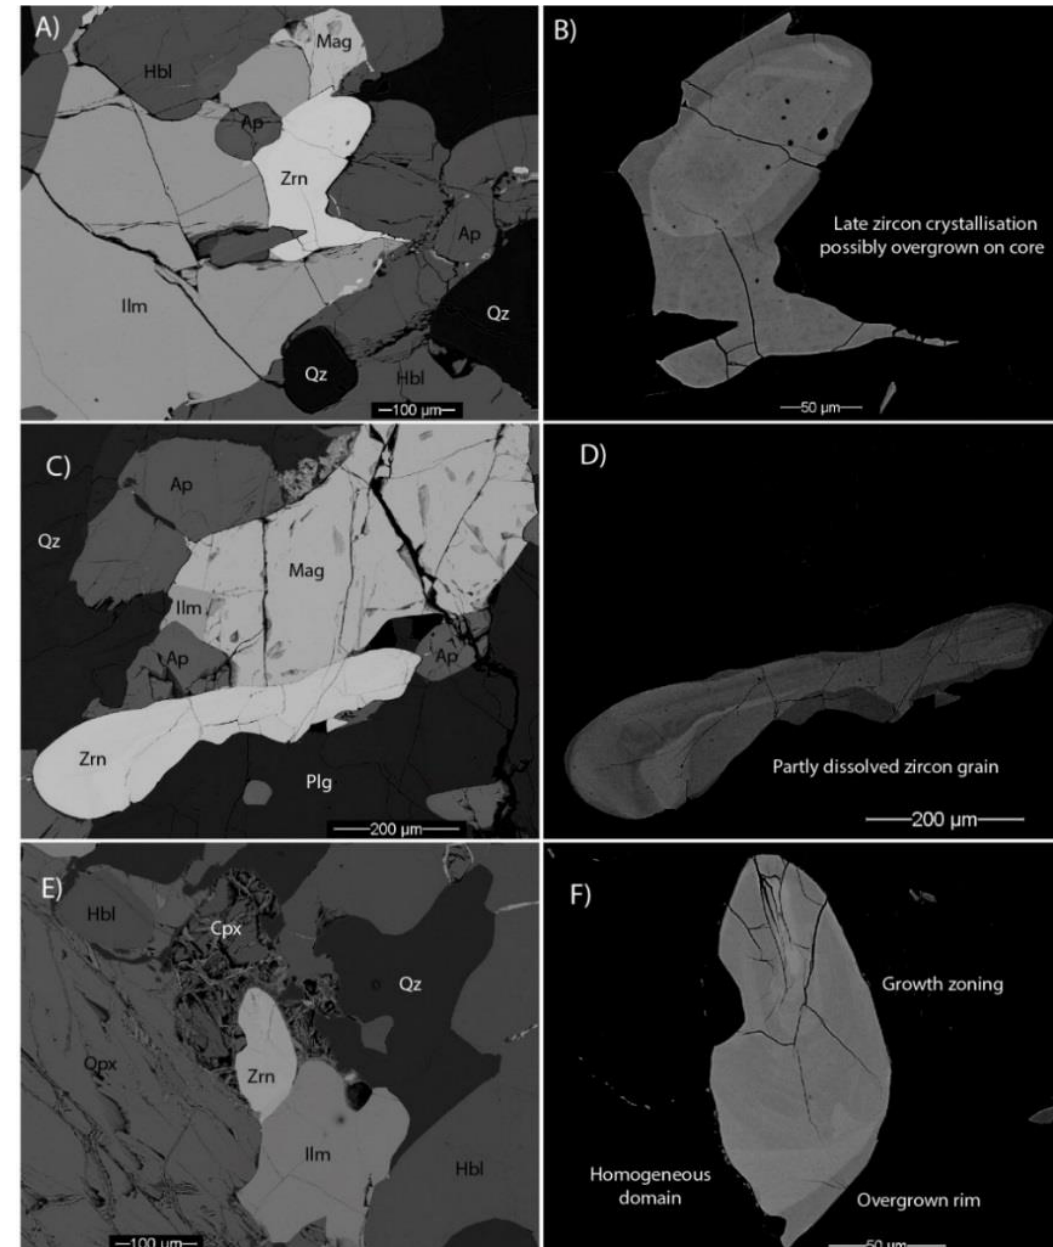
Figure 3. Textural relationships of zircon grains. ( A , B ) Zircon grain in relation to ilmenite, magnetite, apatite and hornblende (sample 468691). ( C , D ) partly dissolved zircon grain (sample 468691). ( E , F ) Zircon grain situated with strongly altered cpx grain. At the border zone toward the ilmenite, the zircon grain seems to be overgrown with a small rim (sample